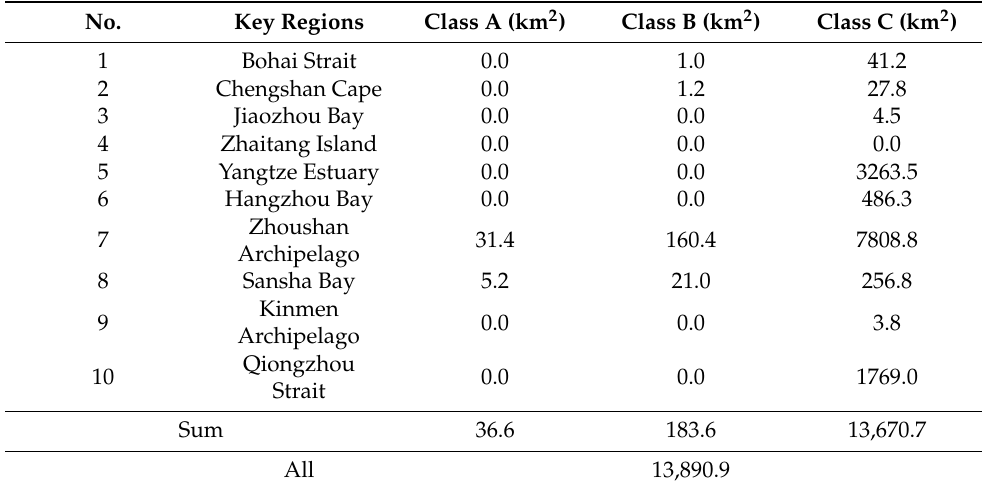
Table 4. Tidal current energy resource reserves of several key regions in 2010 national assessment